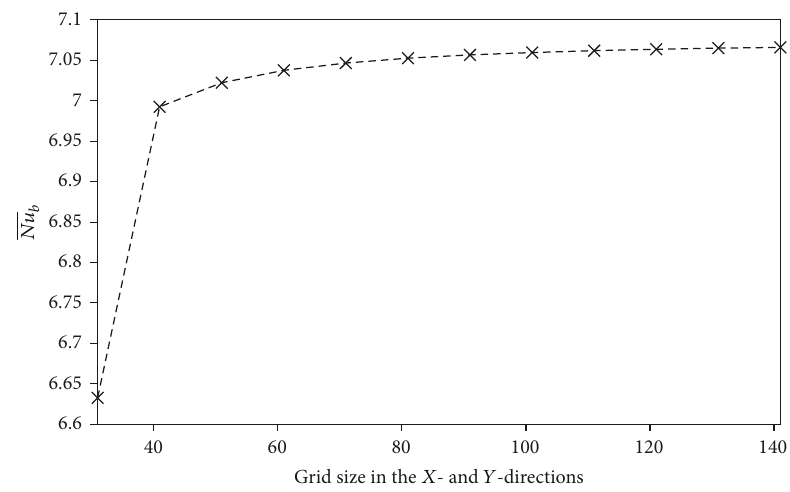
Figure 2: Grid independency study: 𝑁𝑢 𝑏 versus number of grid points.